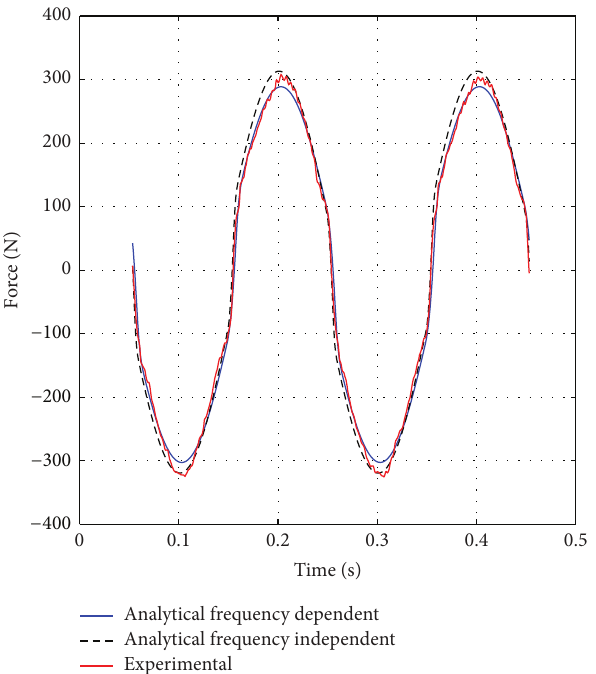
Figure 9: MR damper force in frequency 5 Hz and zero